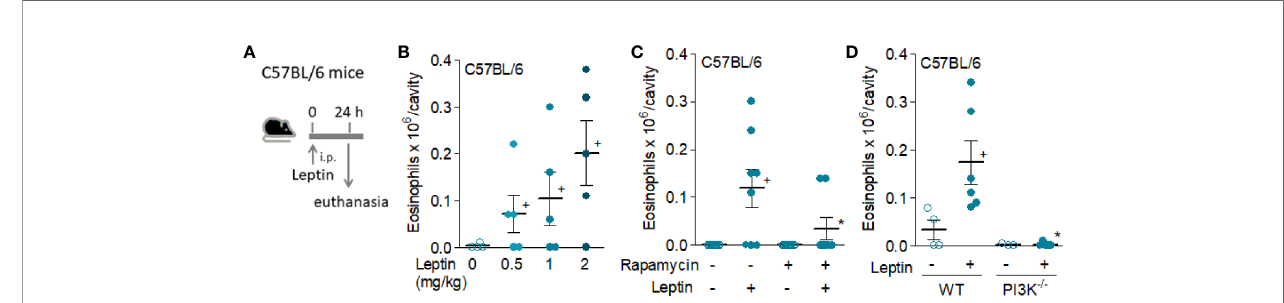
FIGURE 1 | Leptin induces in vivo eosinophil migration in naive C57/BL6 mice by a mechanism involving activation of mTOR and PI3K. Panel (A) shows a brief schematic representation of the peritonitis model induced by i.p. injection of leptin in C57BL/6 mice employed in this study [data shown in (B – D) ]. Leptin was injected into peritoneal cavities of naïve C57BL/6 mice. Peritoneal cells were collected and stained by May – Grünwald – Giemsa for eosinophil recruitment analysis within 24 h of leptin stimulation. In (B) , different concentrations of leptin (0.5, 1, and 2 mg/kg) were used. In (C) , pre-treatment with rapamycin (12.5 m g/kg per injection) 12 h before, 15 min before, and 12 h after leptin injection (1 mg/kg) was performed. In (D) , naïve wild type or PI3K de fi cient C57BL/6mice received i.p. injection of leptin (1 mg/kg) and peritoneal fl uids were collected within 24 h of stimulation. There are no signi fi cant differences between the number of peritoneal eosinophils recovered from the control groups of wild type and PI3K g − / − C57BL/6 mice. Values are expressed as the mean ± SEM (experiments were repeated at least once). + p < 0.05 compared to control group.* p < 0.05 compared to